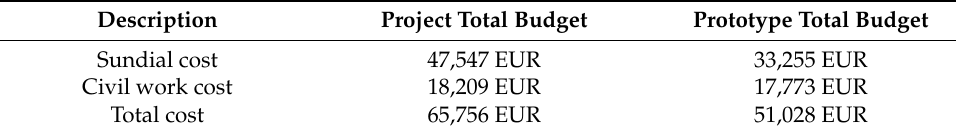
Table 2. Summarized cost, total cost, and prototype cost.